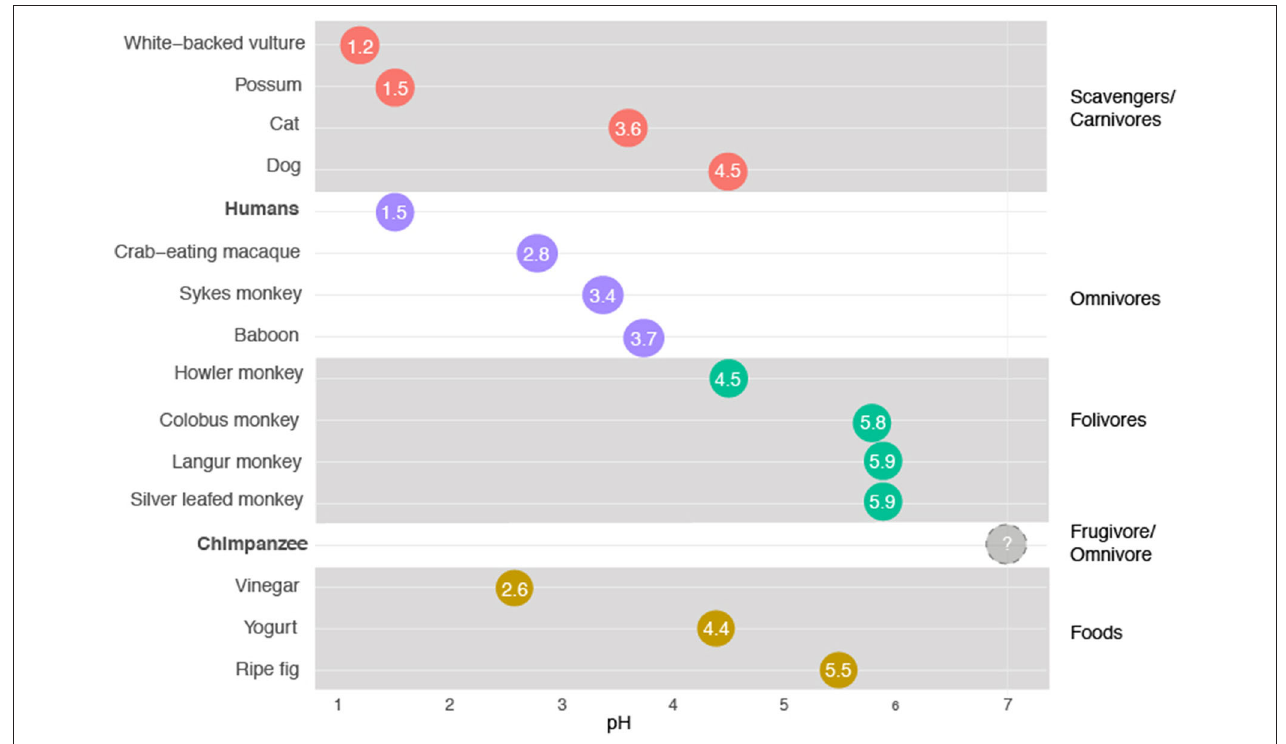
FIGURE 1 | Stomach pH as a function of animal species. A pH of 7 is neutral. Data for chimpanzees come from a single laboratory study of a single individual chimpanzee. A sampling of acidic foods eaten by modern humans is included for reference.